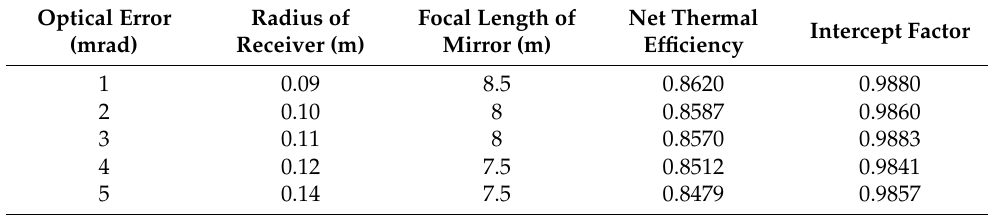
Table 3. The annual thermal efficiency under optimal design with the same focus length of the